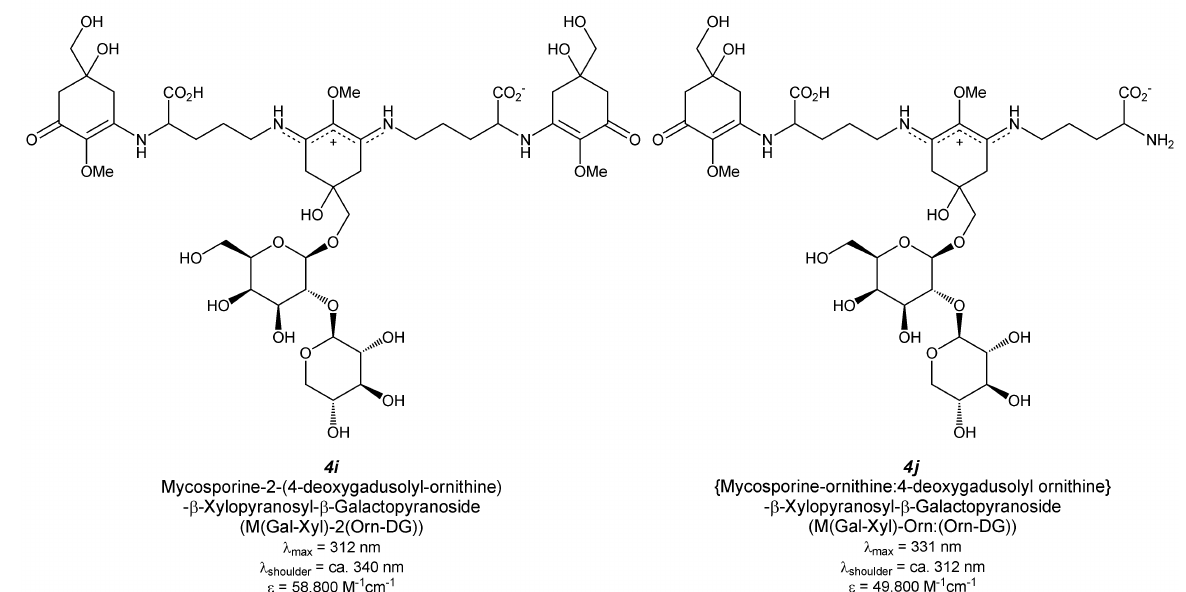
Figure 5. Chemical structures and spectroscopic properties of derivatized MAAs. Abbreviations are in